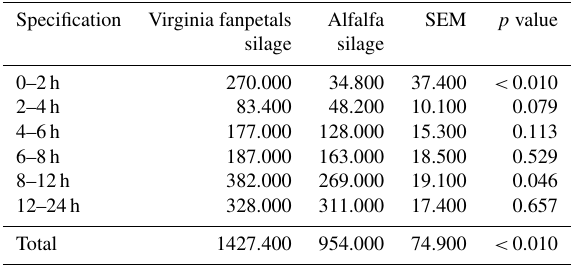
Table 3. Voluntary intake of silage in a preference test (g DM).